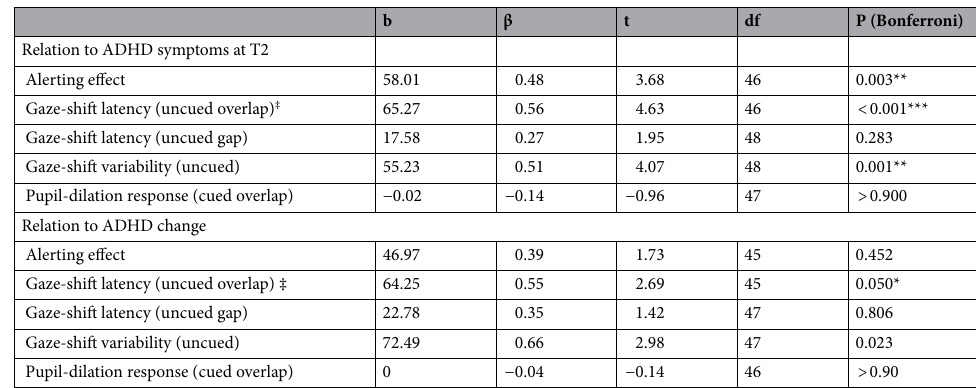
Table 2. Relations between eye-movement measures, symptoms of ADHD at T2, and change in ADHD symptoms from T1 to T2. ADHD attention-deficit/hyperactivity disorder. * p < 0.05, ** p < 0.01, *** p < 0 . 001 (Bonferroni-corrected). ‡ 1 outlier observation removed. Unstandardized b coefficients indicate the predicted change in ms (gaze-shift latency) or pupil size (mm).